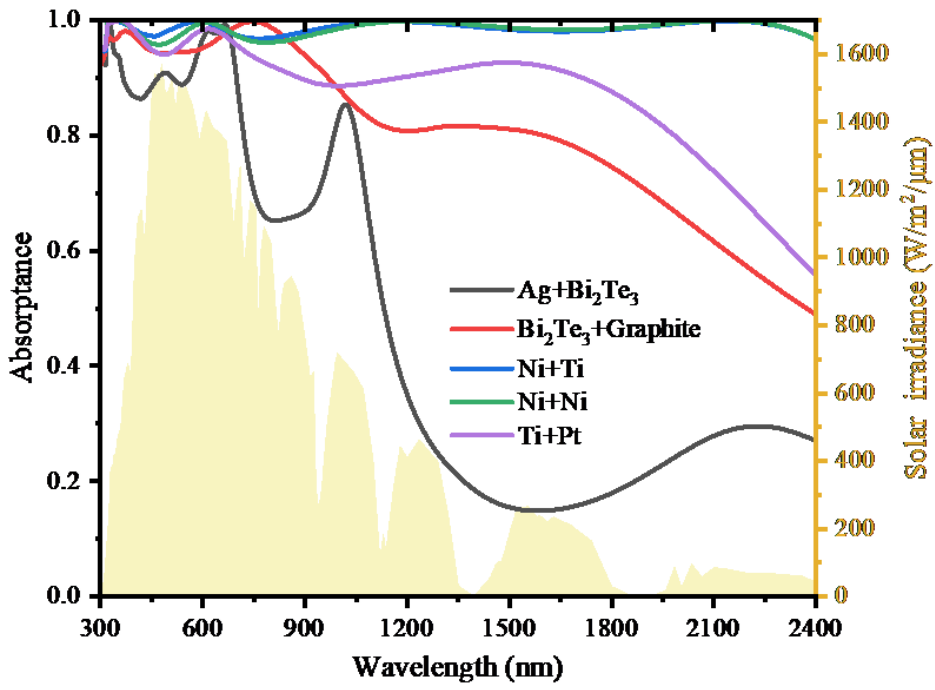
Figure 7. The absorption spectra of the absorbers with different